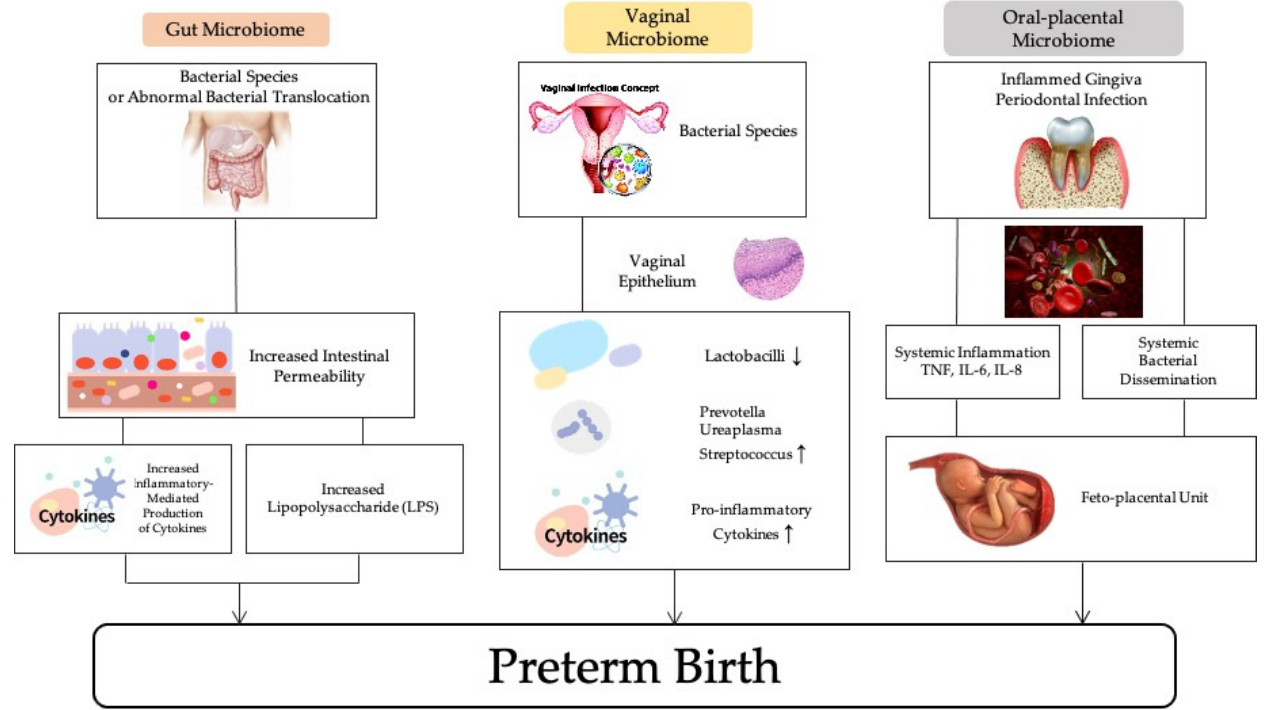
Figure 1. The association of maternal microbiomes and preterm birth.